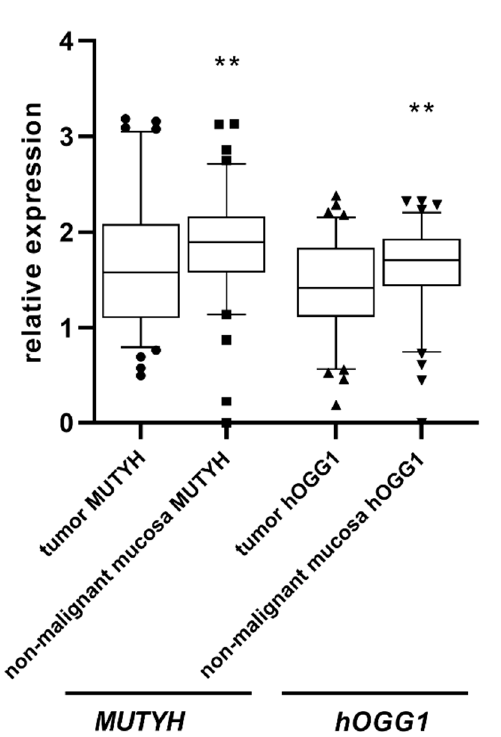
Figure 1. MUTYH and hOGG1 relative gene expression showed higher level in non-malignant mucosa than in corresponding tumor tissue (** p = 0.0038 for MUTYH and ** p = 0.0016 for hOGG1, all data are showed as median with 5–95th percentile, Mann-Whitney test; n = 91).